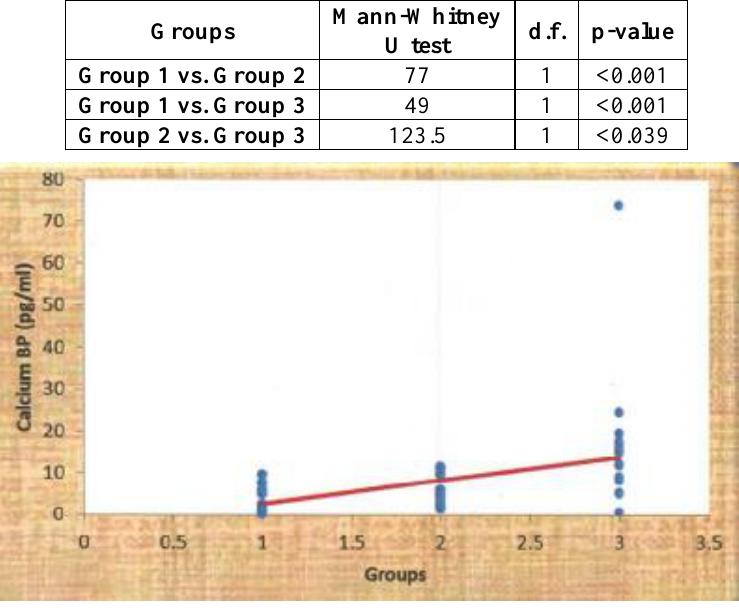
Fig. 2: Regression analysis between smoking and salivary CB protein level in groups enrolled in the present study (1= non-smoker no carcinoma, 2= smoker no carcinoma, 3=smoker with